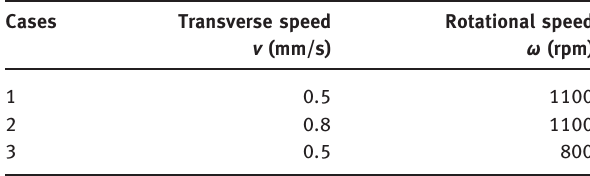
Table 1: Welding parameters for the simulated cases.